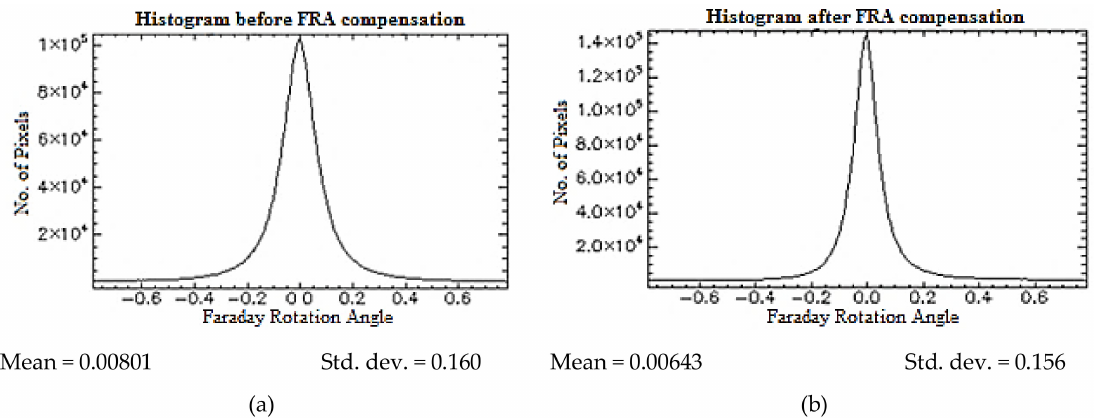
Figure 11. Histogram of the Faraday rotation angle ( Ω ) image: ( a ) before compensation, and ( b ) after compensation.